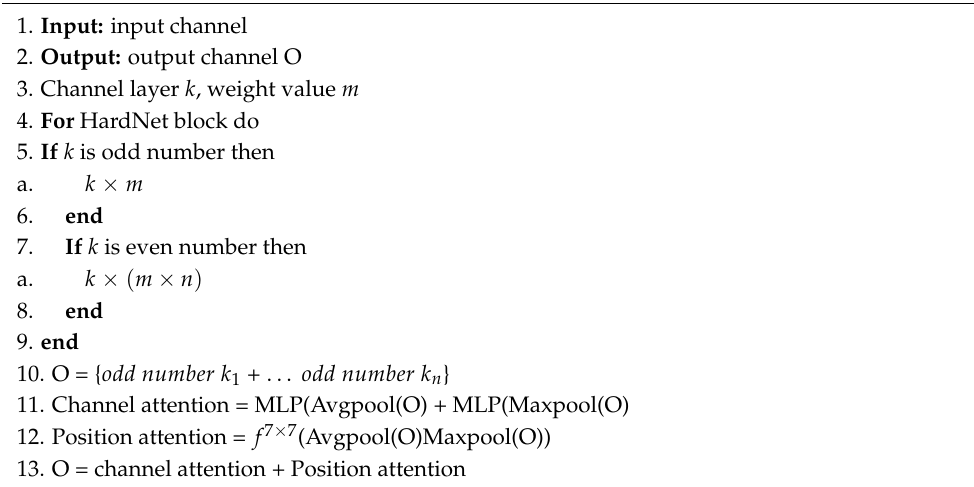
Figure 3. The proposed final attention HardNet structure. Algorithm 1 The proposed final attention HardNet